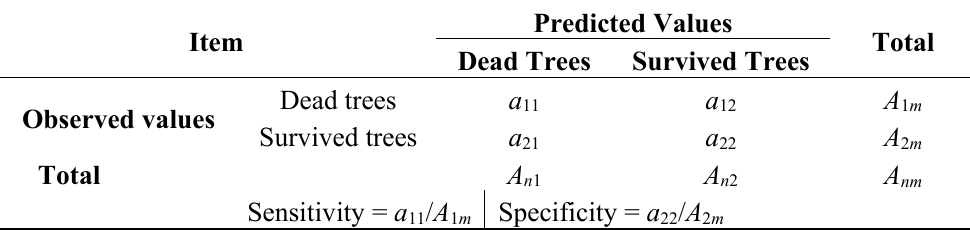
Table 2. Contingency table of the observed values and predicted